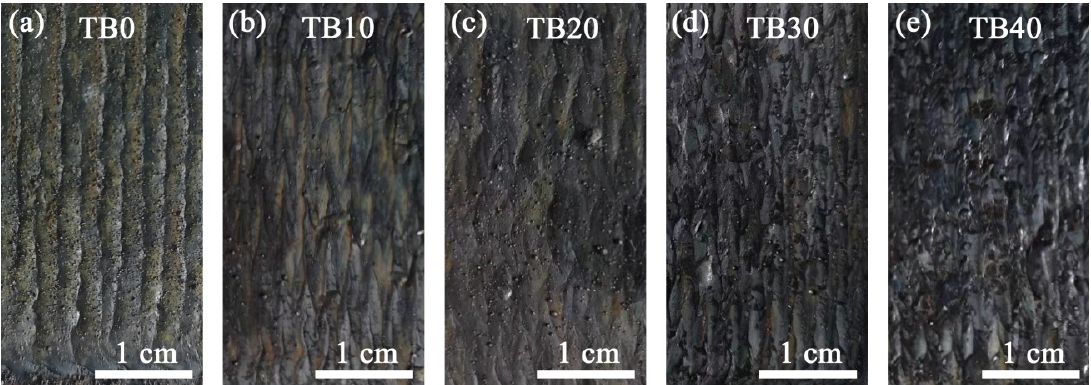
Figure 3. Surface morphologies of coatings with different TiB 2 particles content: ( a ) TB0, ( b ) TB10, ( c ) TB20, ( d ) TB30 and ( e ) TB40.